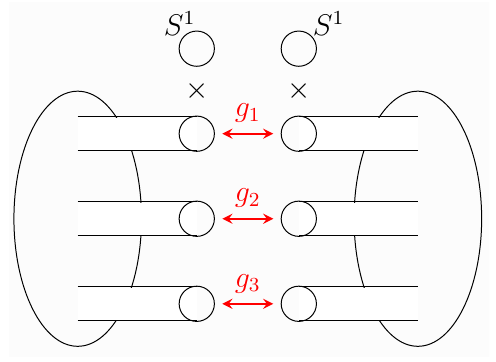
Figure 11 . A further generalization of figure 10.